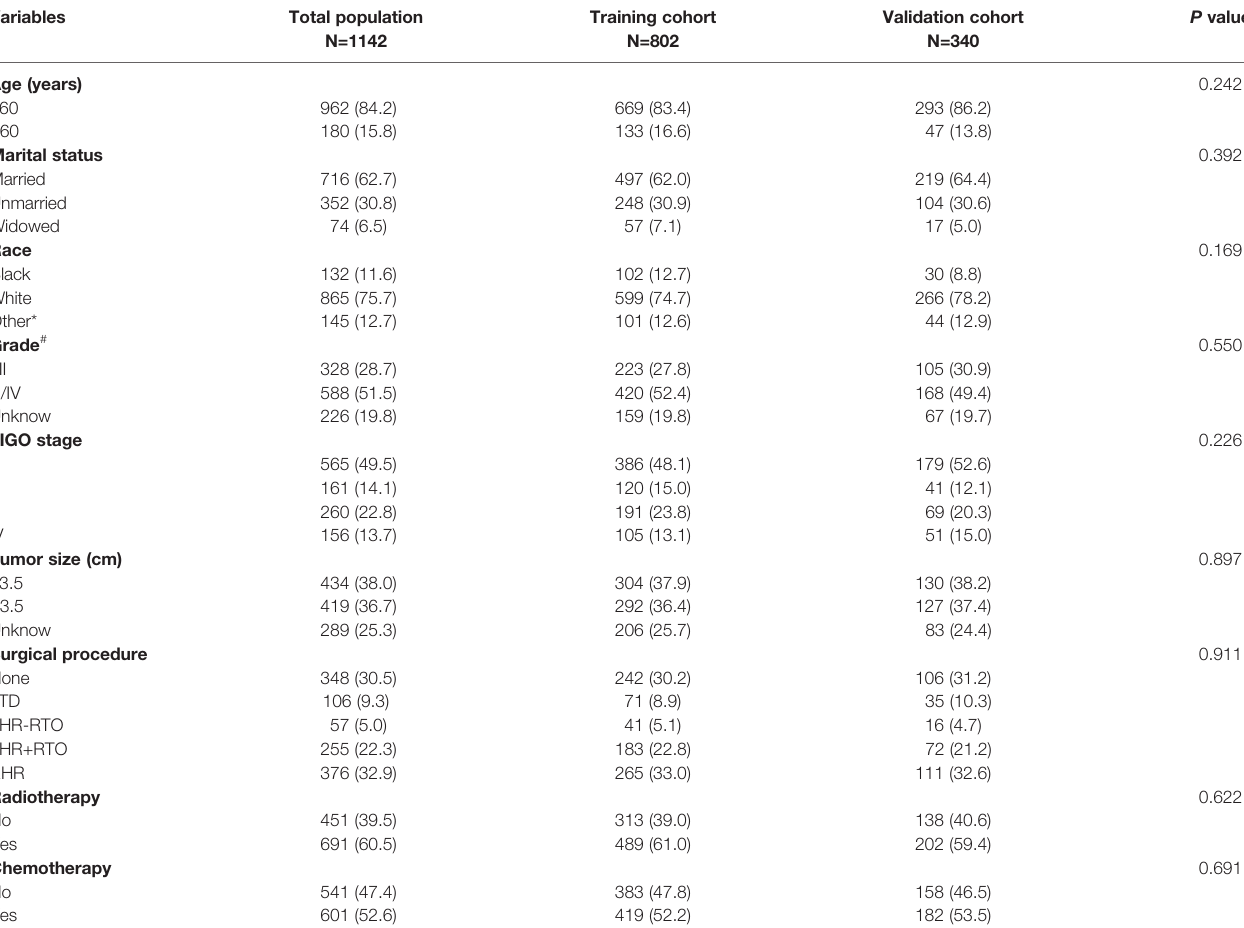
TABLE 1 | Clinical features of ASCC patients in the total, training, and validation cohorts. Variables